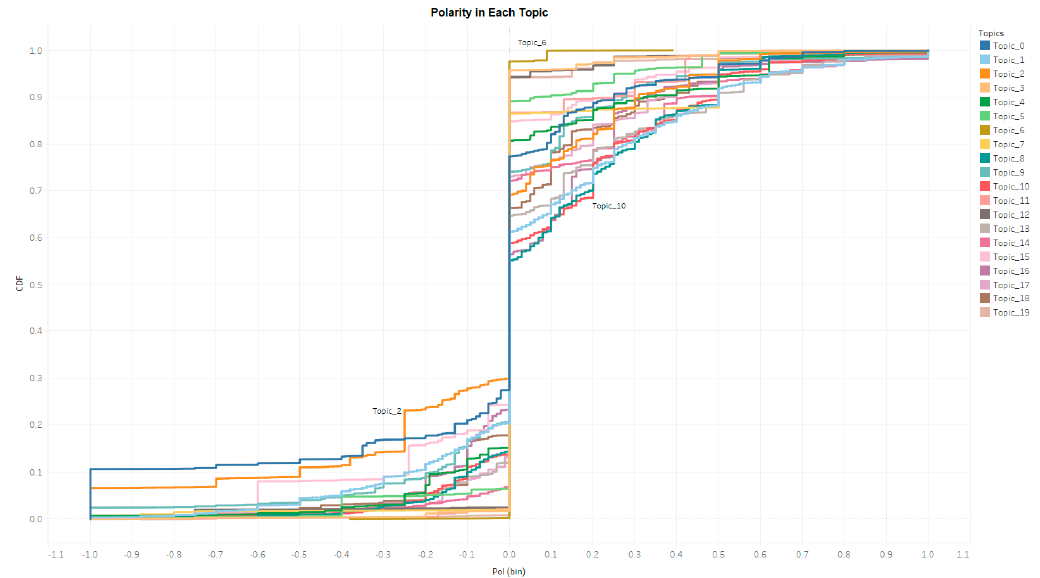
Figure 3. Polarity in each topic.